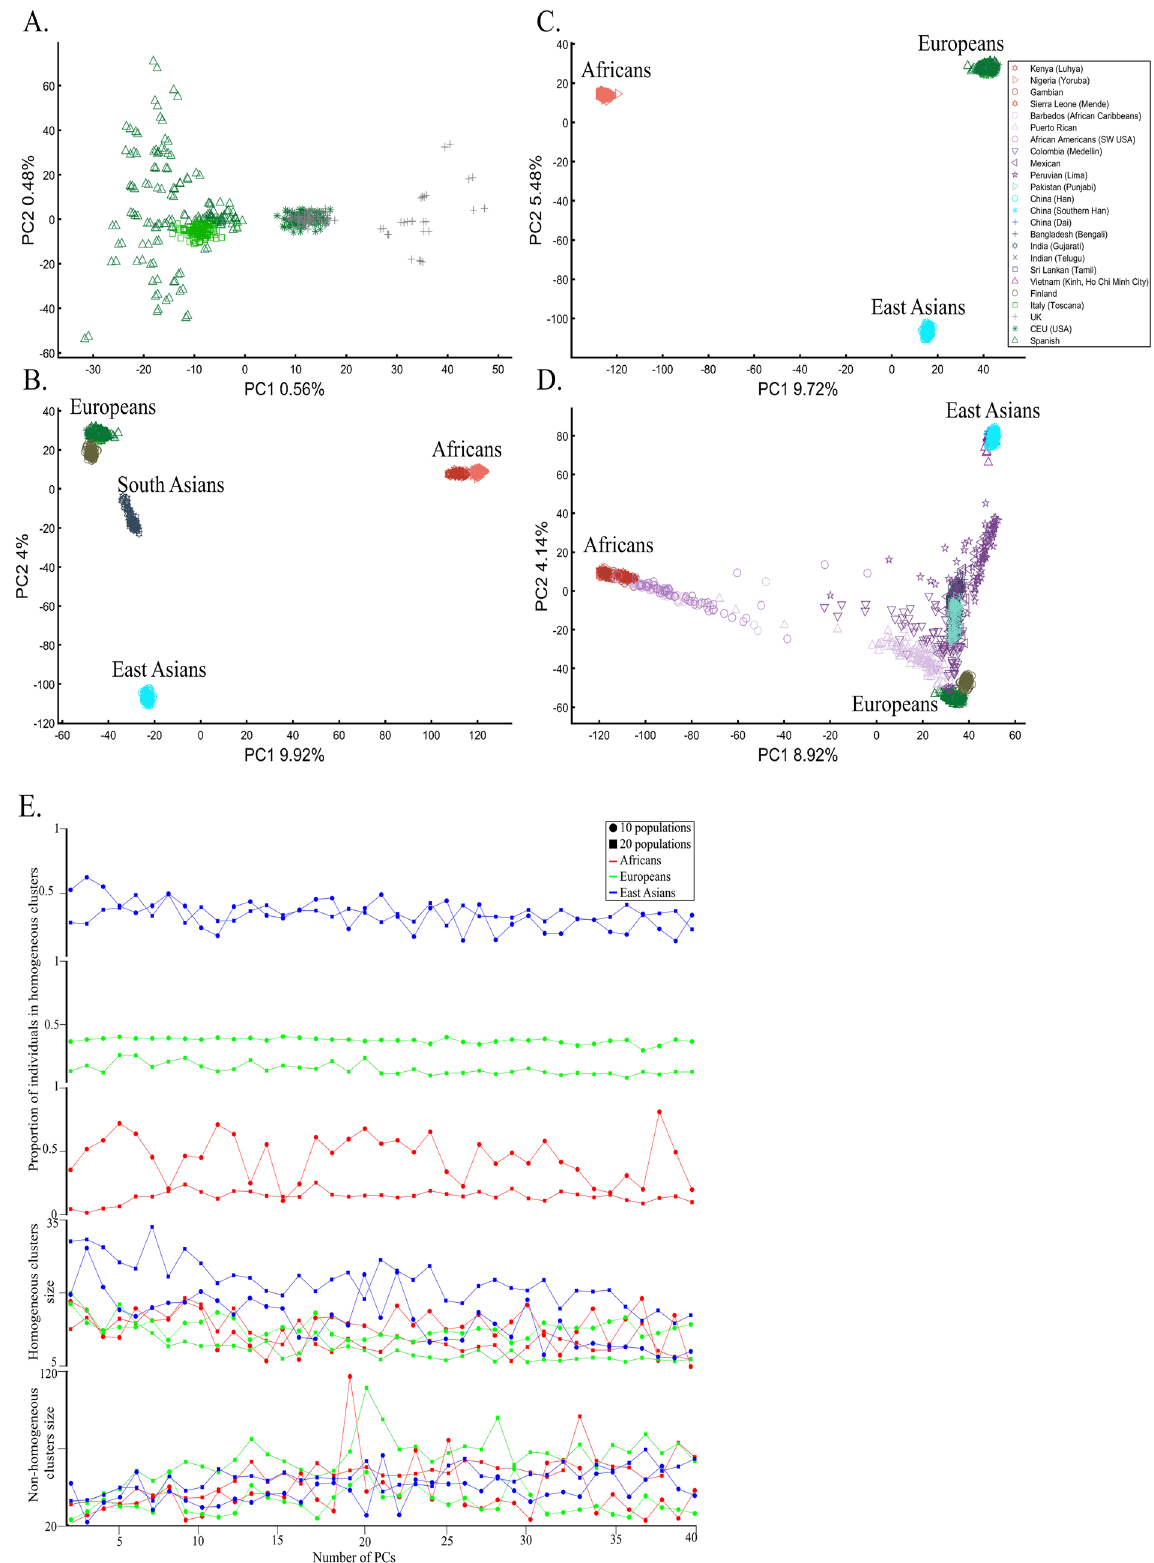
Figure 14. Evaluating the cluster homogeneity of European samples. PCA was applied to the four European populations (Tuscan Italians [TSI], Northern and Western Europeans from Utah [CEU], British [GBR], and Spanish [IBS]) alone ( A ), together with an African and Asian population ( B ), as well as South Asian population ( C ), and finally with all the 1000 Genomes Populations ( D ). ( E ) Evaluating the usefulness of PCA-based clustering. The bottom two plots show the sizes of non-homogeneous and homogeneous clusters, and the top three plots show the proportion of individuals in homogeneous clusters. Each plot shows the results for 10 or 20 random African, European, or Asian populations for the same PCs ( x